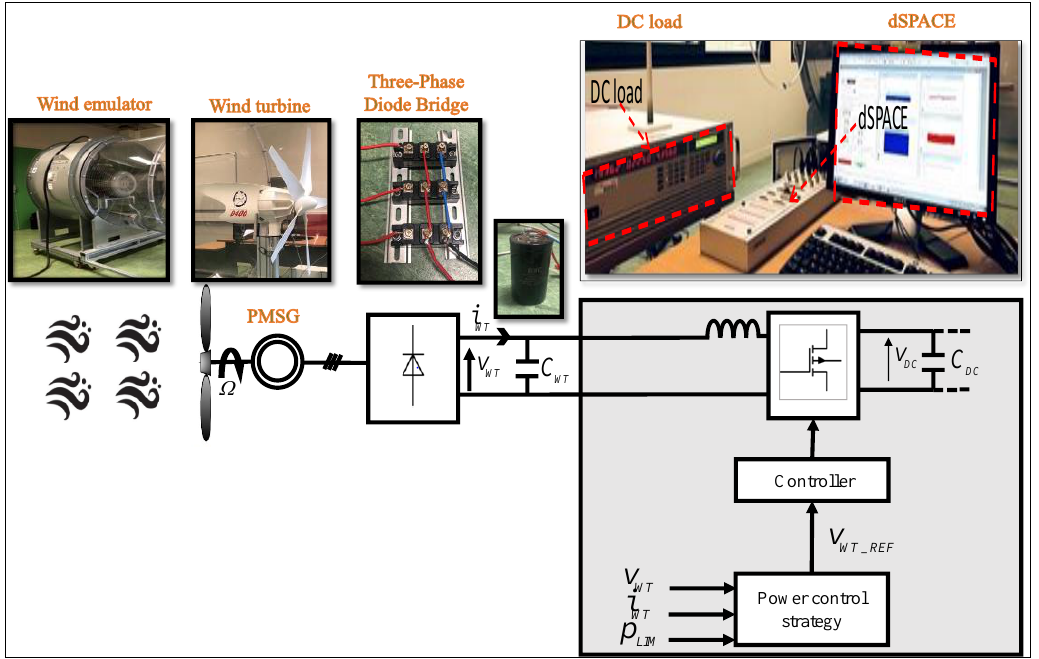
Figure 3. Electrical scheme and components of the studied small wind energy conversion system (SWECS).